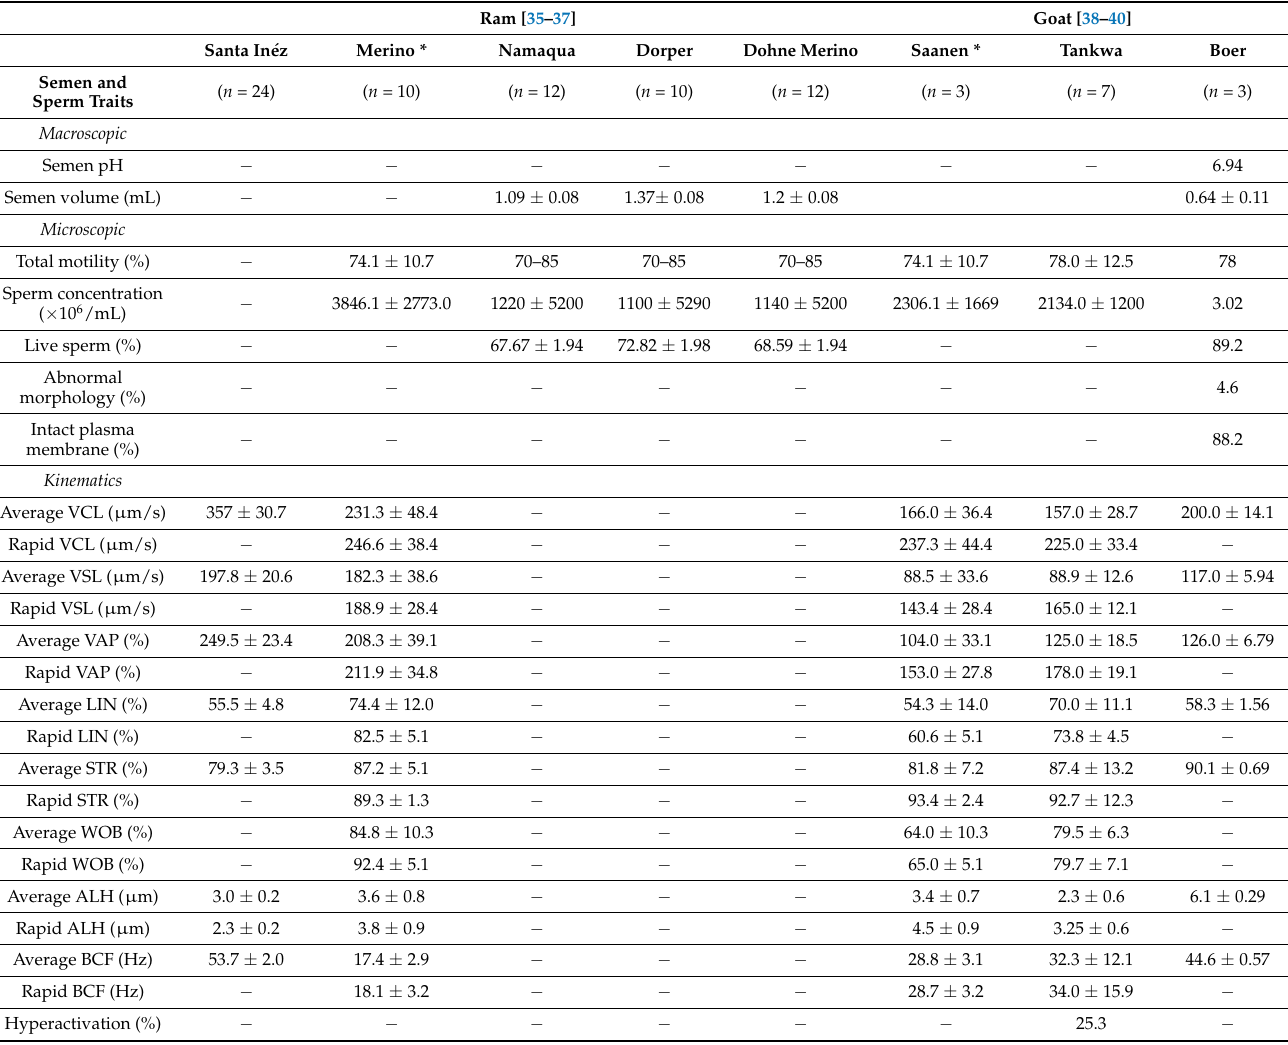
Table 5. Comparison of semen and sperm characteristics of indigenous and exotic ram and goat breeds. In instances where a parameter is only presented for one breed, these values are included for future